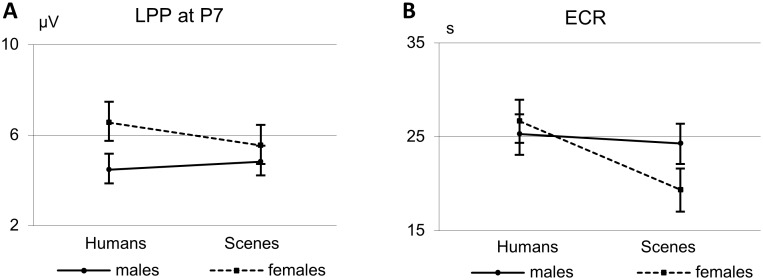
Means and SEMs of the LPP values (average amplitudesof the 550 to 700 ms interval) at P7 (a) and the baseline-adjusted maximal IBIs (b) illustrating the sex differential Human effects.